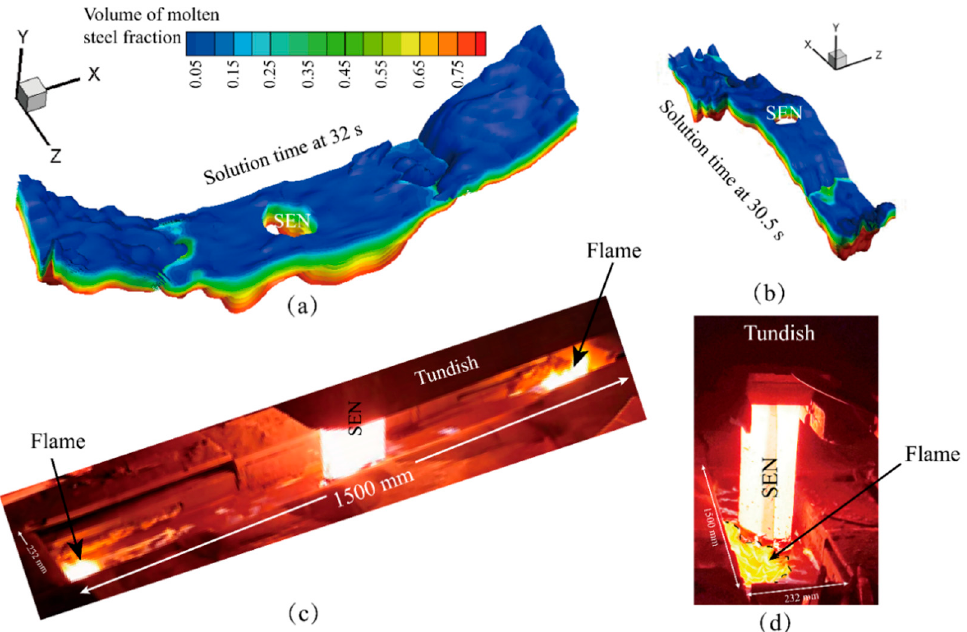
Figure 13. Comparison of steel–slag interface feature between ( a ) simulation result at 32 s, ( b ) simulation results at 30.5 s, and ( c , d ) experimental results for casting 260 tons Al-killed ultra-low carbon steel in different views.